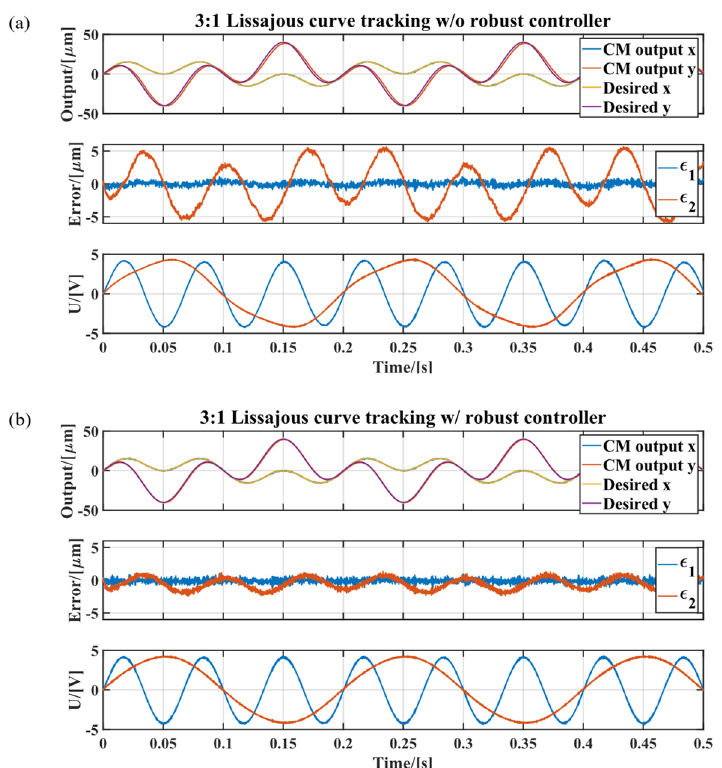
Figure 9. Experiment result showing a comparison between ( a ) Tracking of 3:1 Lissajous curve without the robust controller and ( b ) Tracking of 3:1 Lissajous curve with the robust controller.